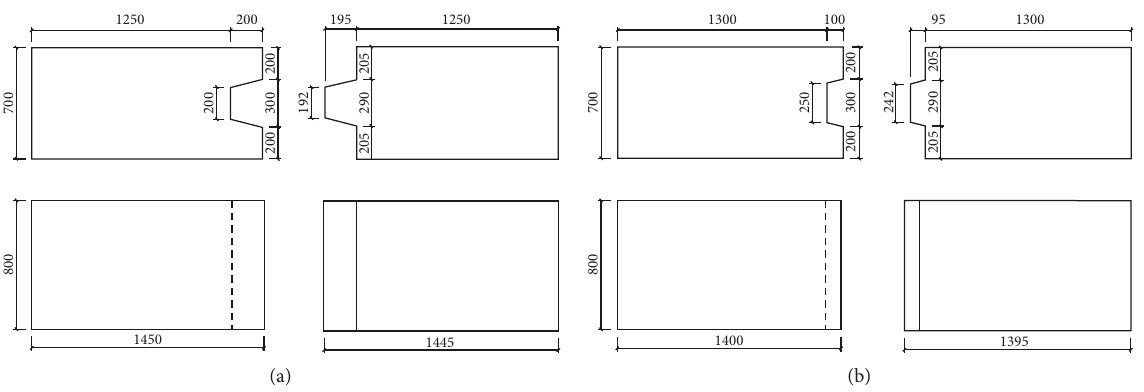
Figure 6: Plan and facade view of experimental specimens: (a) long joint and (b) short joint (all dimensions are in